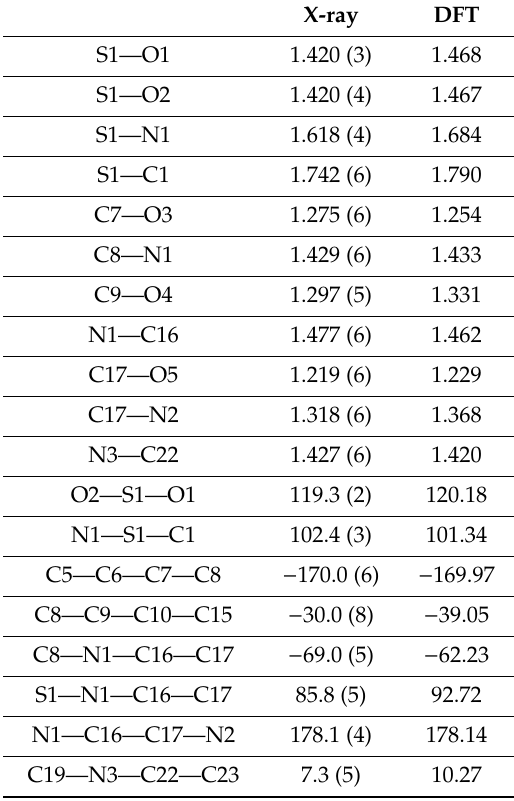
Figure 1. View of the X-ray molecular structure of 7i showing displacement ellipsoids at the 30% probability level and H atoms as a sphere of arbitrary radii ( a ) and fully optimized DFT geometry ( b ). Dashed lines represent the intramolecular O-H ··· O hydrogen bonds. Table 1. Selected geometrical parameters (Å, ◦ ) for 7i .